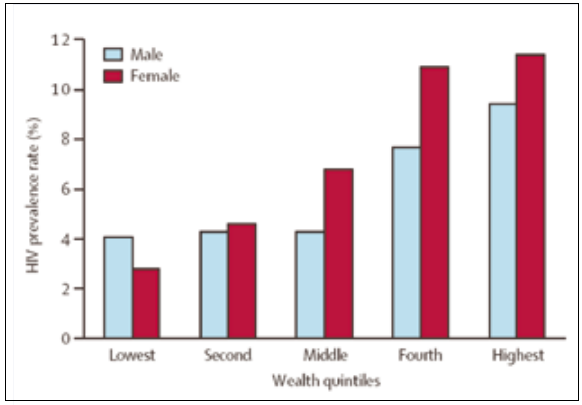
Fig. 2. HIV prevalences for males and females by wealth quintiles in Tanzania.